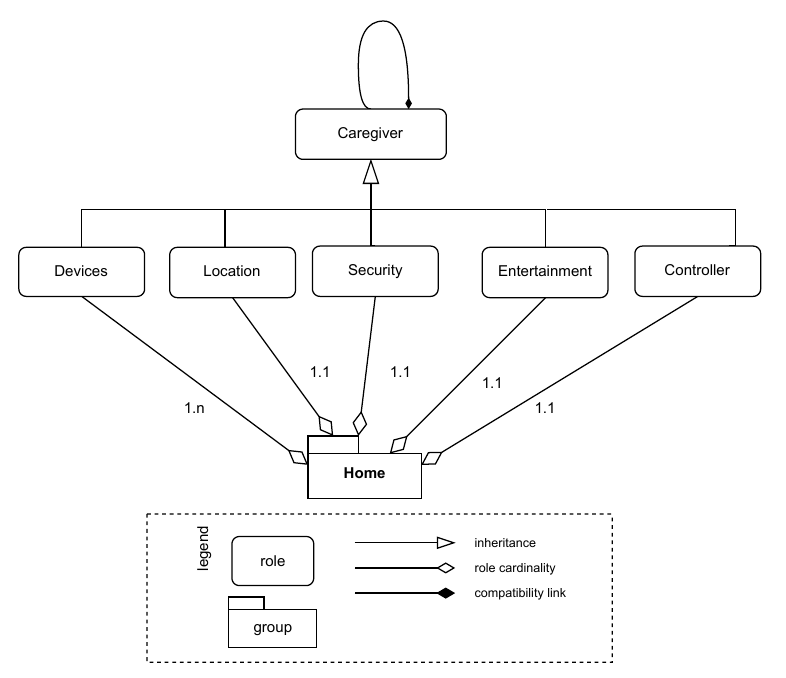
Figure 4. Multi-agent